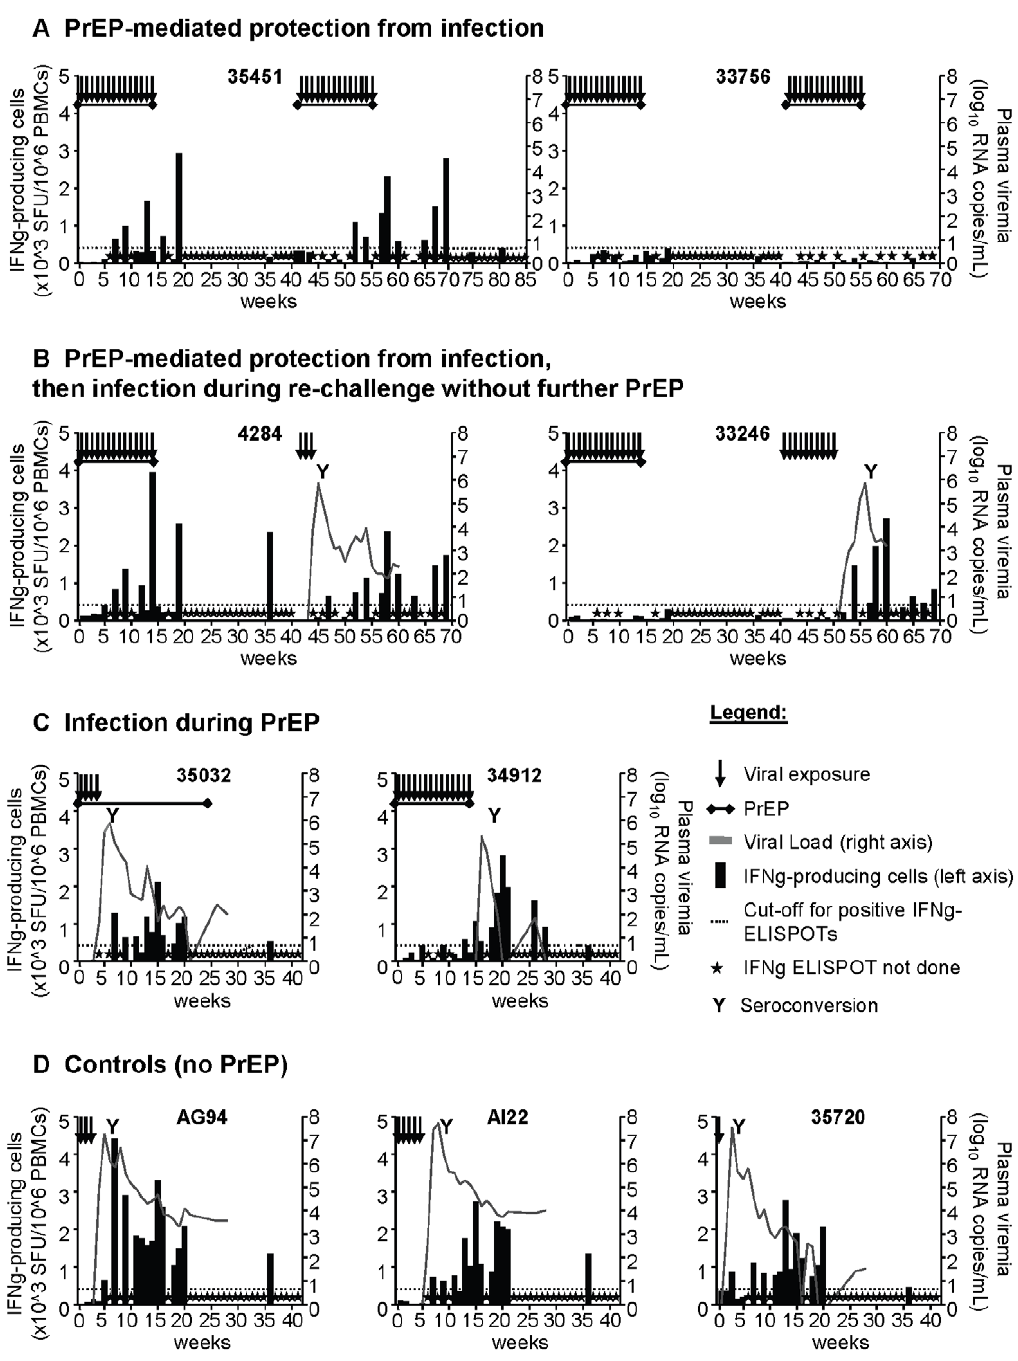
Figure 2. Chemo-vaccination effect. SHIV-specific T cells are induced in two PrEP-protected macaques during PrEP and virus exposures. PrEP protected four macaques from infection during 14 SHIV exposures in weeks 1–14 ( A and B ), while two became infected despite PrEP ( C ); three macaques were controls ( D ). SHIV-specific T cells were determined by IFN c -ELISPOT. The black bars represent the number of specific T cells as a sum of responses to 14 SHIV-derived peptide pools for antigenic simulation, measured in SFU (spot forming units, left axis). Grey lines depict plasma viremia (right axes). The graphs represent data from individual macaques, their identification codes are bolded. The dotted lines are cut-off values for positive T cell responses. Two PrEP-protected macaques (35451 ( A ), 4284 ( B )) showed signs of chemo-vaccination. During re-challenge with 14 SHIV exposures in weeks 42–55, additional PrEP protected macaques 35451 and 33756 ( A ). Chemo-vaccinated macaques 4284 and 33246 were not protected from SHIV infection ( B ). Throughout the study, anti-SHIV antibodies were determined every 6 weeks (weeks 1–41) or 4 weeks (weeks 42– 69). ‘‘Y’’ indicates time of seroconversion.